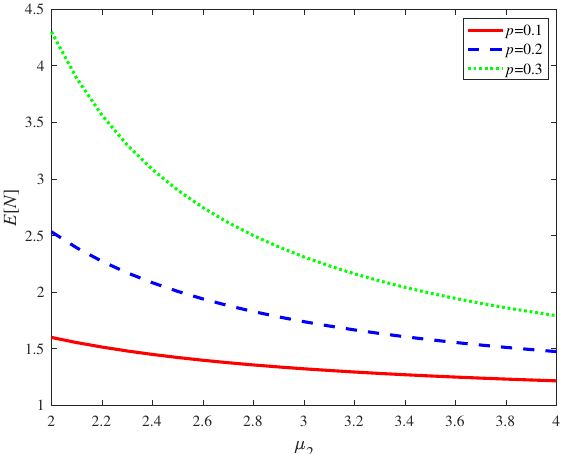
Figure 5. Relation between E [ N ] and µ 2